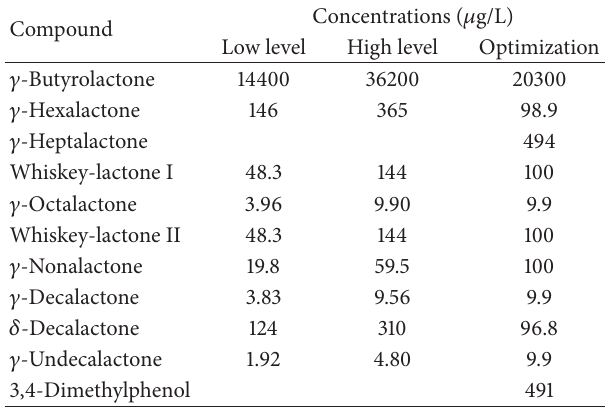
Table 1: Concentrations of synthetic solutions containing